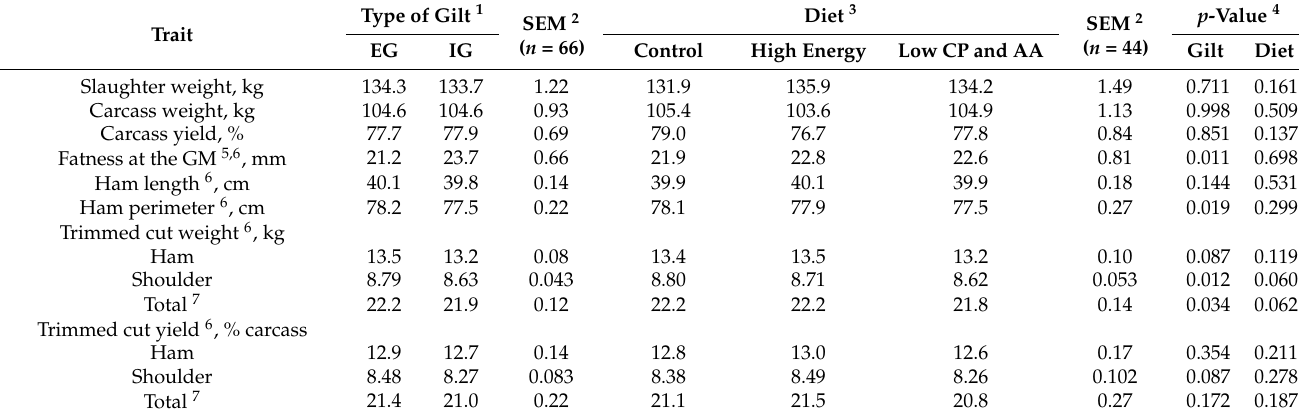
Table 7. Impact of immunocastration and diet on carcass quality (least square means) of heavy gilts. Type of Gilt 1 Trait Slaughter weight,